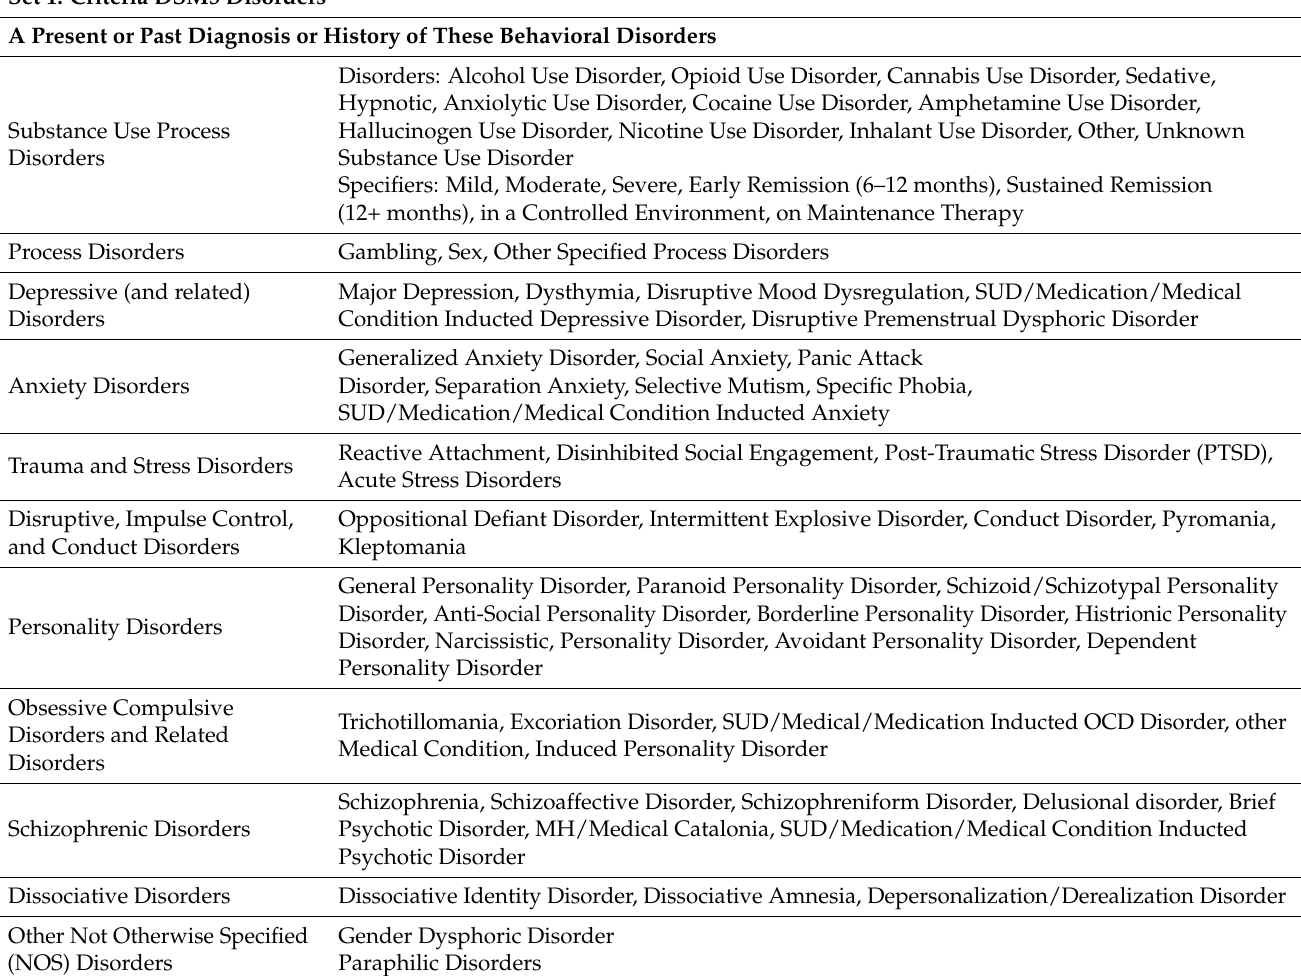
Table 1. Reward Deficiency Syndrome